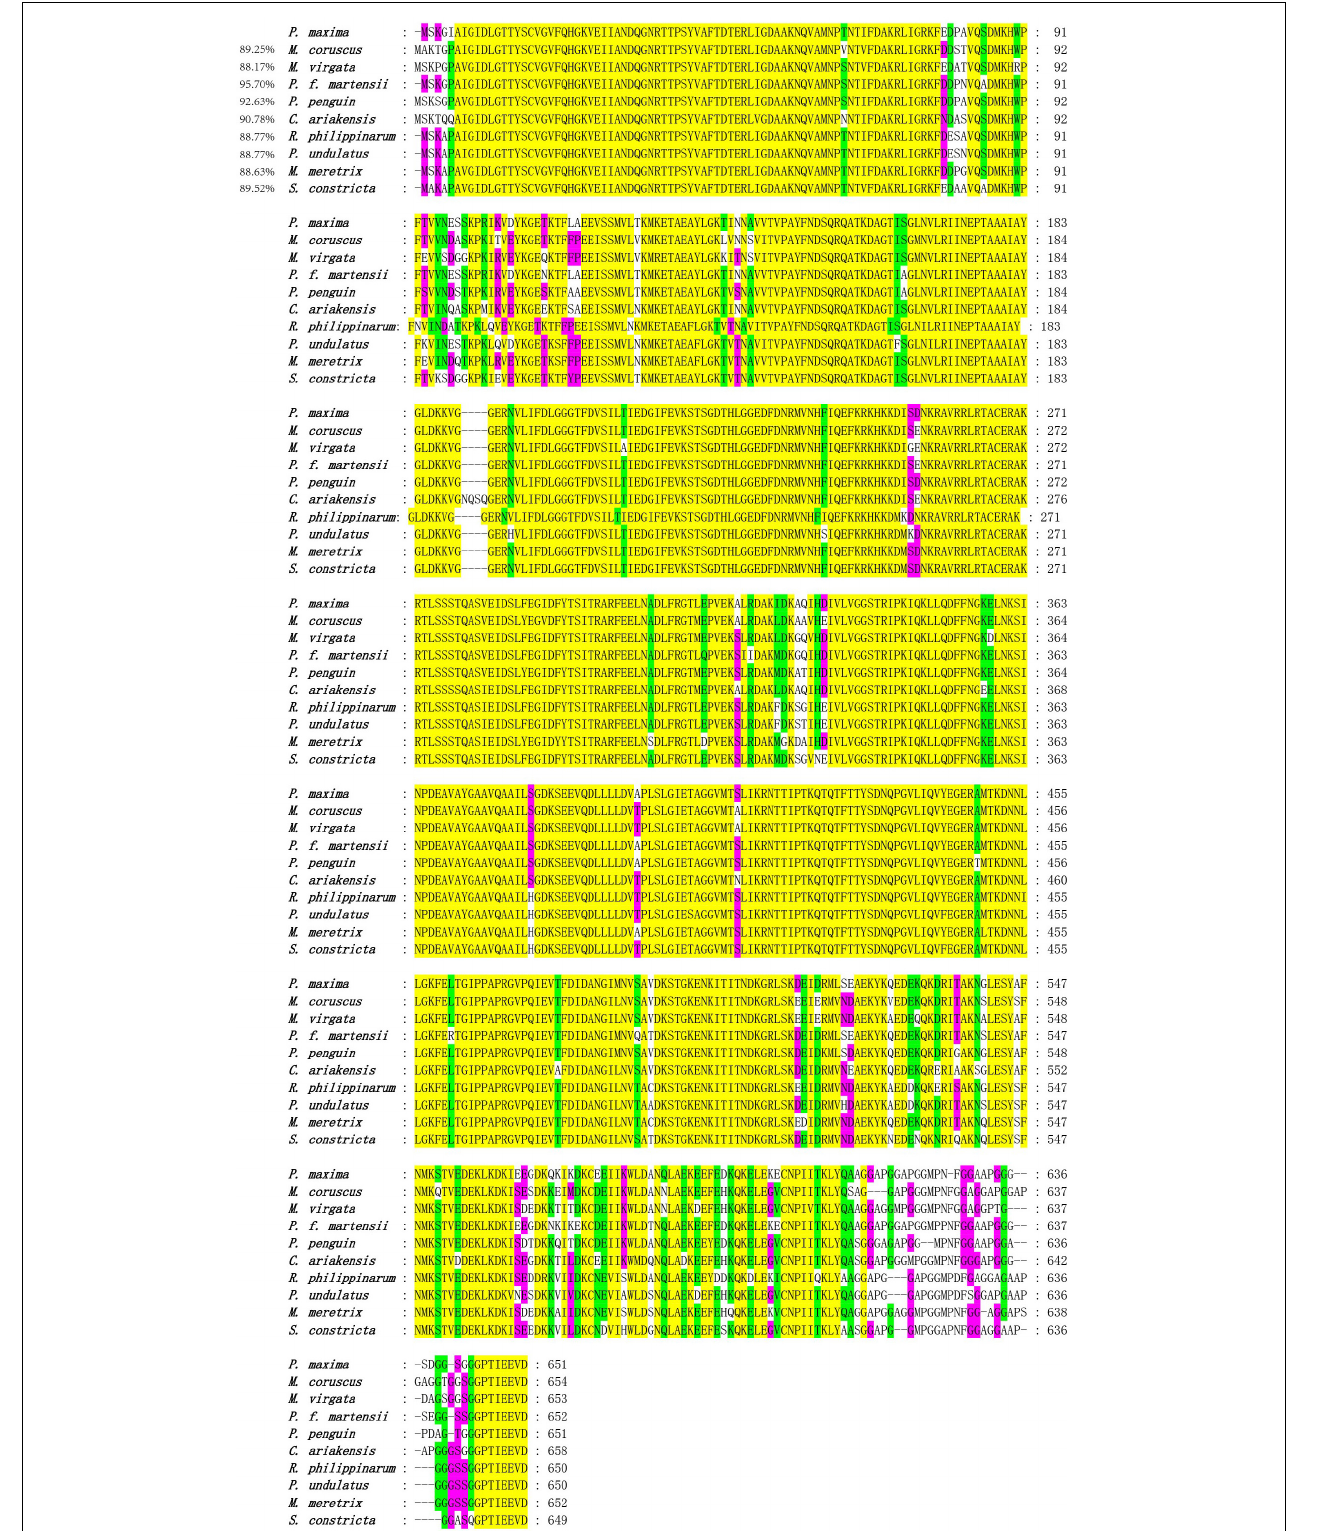
FIGURE 3 | Multiple alignment of the deduced amino acid sequences of HSP70 from P. maxima and other organisms. Yellow means 100% homology, green means homology greater than 90%, purple means homology greater than 80%.